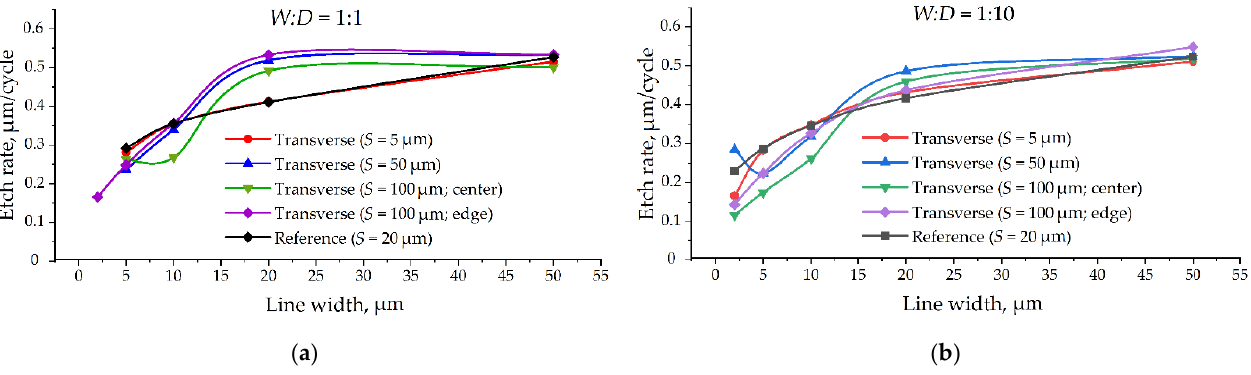
Figure 9. Etching rate depending on the target lines width: ( a ) For W:D = 1:1 aspect ratio; ( b ) For W:D = 1:10 aspect ratio.